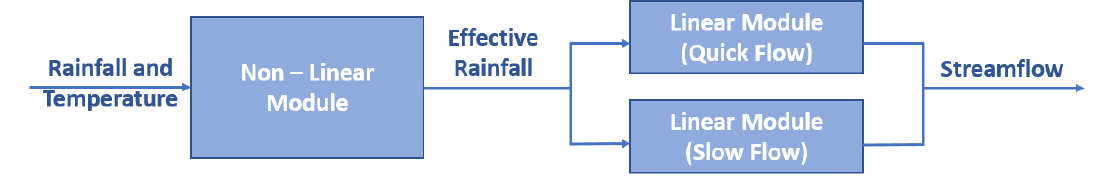
Figure 3. IHACRES model structure.